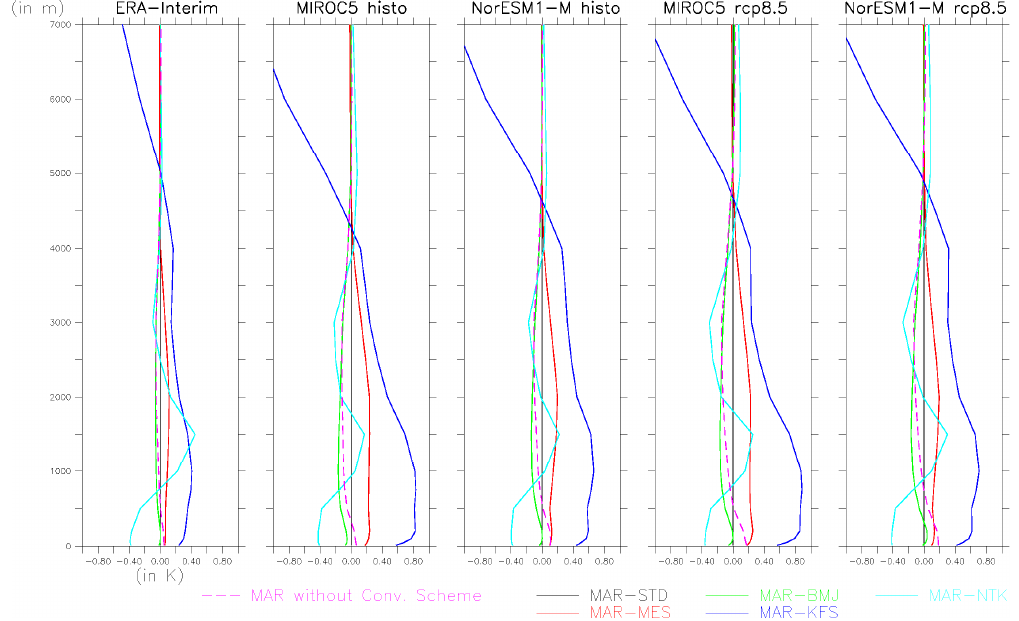
Figure 8. Anomalies of annual mean vertical temperature profiles (in °C) between all MAR experiments and the MAR-STD experiment between the surface and 7000 m above the surface. The vertical profiles are here averaged over Belgium.